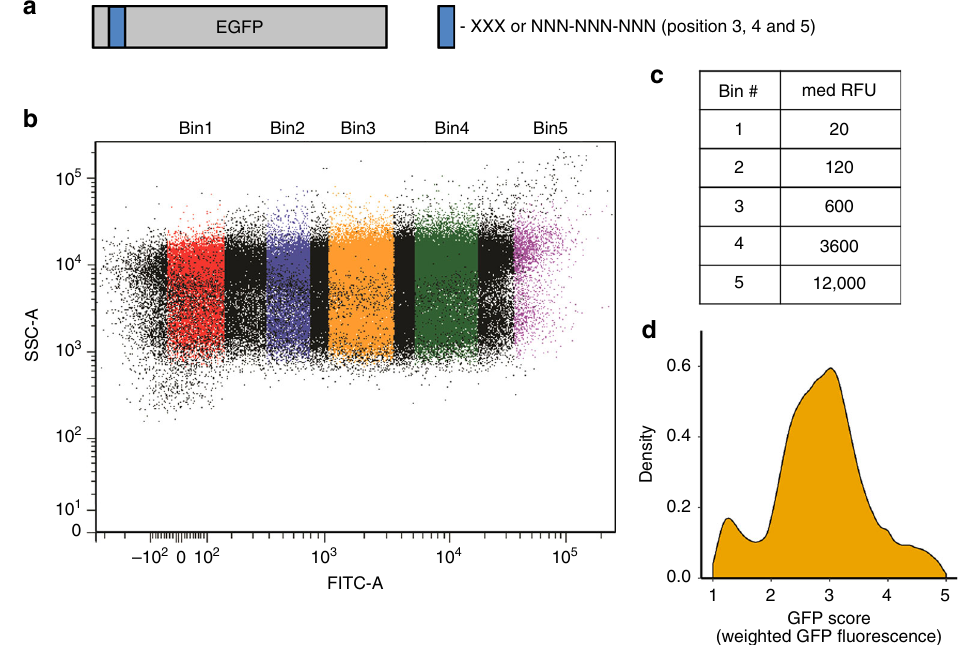
Fig. 1 Fluorescence-based screen identi fi es large differences in protein synthesis as a result of the identity of the N-terminus. a Scheme of the reporter system to test the in fl uence of the fi rst fi ve amino acids and mRNA sequence of the fi rst ribosome footprint. Nine random nucleotides were introduced into eGFP reporter in the positions from 7 to 15 nucleotide coding for amino acids 3, 4, and 5 in protein. b Fluorescence-activated cell sorting (FACS) of induced E.coli cells into 5 bins. Bin 1 – 4 each represent approximately 24% of the whole cell population depending on eGFP expression. Bin 5 represents 2.5% of the E.coli cells with highest eGFP expression based on relative fl uorescence values (RFUs). E.coli cells were sorted based on granularity (SSC-A) and eGFP fl uorescence (FITC-A) channels. c Table of relative average fl uorescence values for colonies in fi ve separated bins. Wild type eGFP expression is approximately 250 RFUs. d Distribution of the plasmid reads based on the GFP score. GFP score represents distribution value for each independent sequence in 5